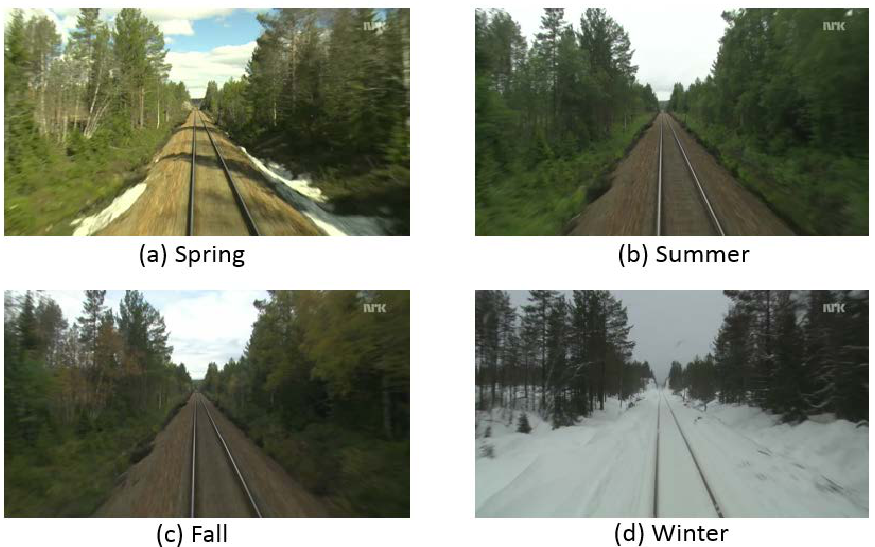
Figure 7. Four representative examples of the Nordland data set (each image corresponds to a different season).